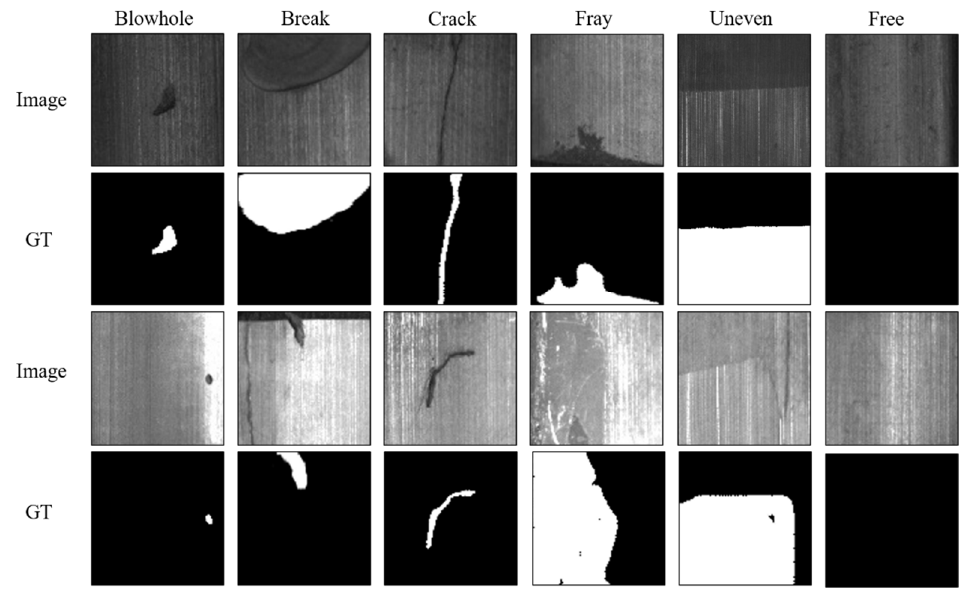
Figure 9. Examples of images from the MT defect dataset.